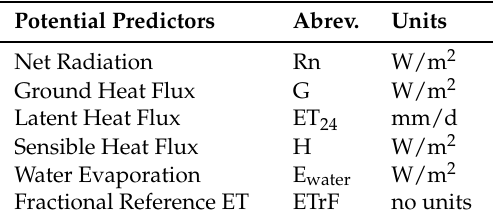
Table 5. METRIC energy balance products used in this